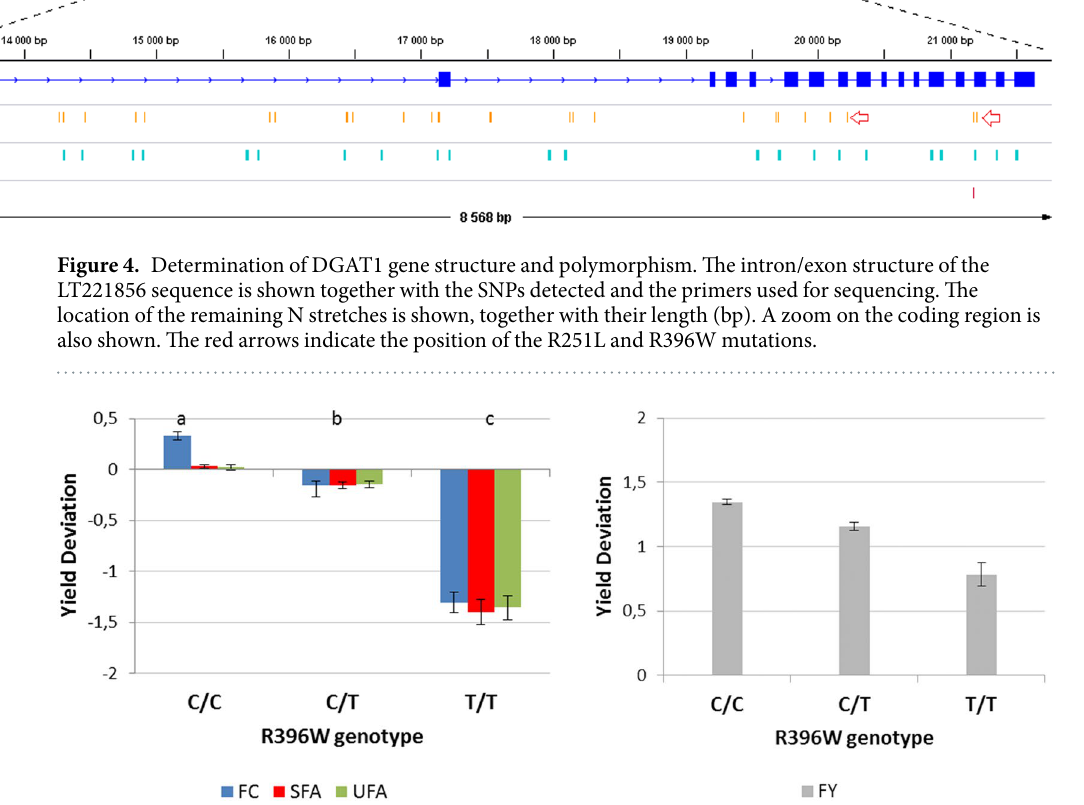
fatty acids in the fat were not significantly affected. The R251L locus only affected fat content. Heterozygous carri- ers (G/T) had a significantly lower average fat content ( − 1.11 g/kg, i.e . − 0.36 SD) than the homozygous wild type (G/G). The LS means of homozygous individuals (T/T)) were not estimated because too few females carried this genotype. The variance in fat content explained by the DGAT1 mutation differed significantly depending on the mutation: 46% for the R396W mutation and 6% for the R251L mutation, respectively. Effect of the R251L and R396W mutations on the enzymatic activity of recombinant DGAT1. These two exonic mutations led to modifications in the amino acid sequence of the DGAT1 protein and were associated with changes in milk composition, e.g. a decrease in fat content. But even though these were the most likely causal mutations, an indirect effect due to linkage with the true genetic variant could not be excluded. A functional test was consequently performed to prove their causality. First, using a baculovirus expression system in Sf21 insect cells (details in the Materials and Method section), one wild type and three different types of recombinant DGAT1 protein were produced: one with the R251L mutation only, one with the R396W muta- tion only and one carrying both mutations. Membrane fractions containing the proteins were prepared and the amount of neo-synthesized triglyceride from diglyceride produced by each membrane preparation under three different conditions was measured by gas chromatography – flame ionization detector (GCFID). The three